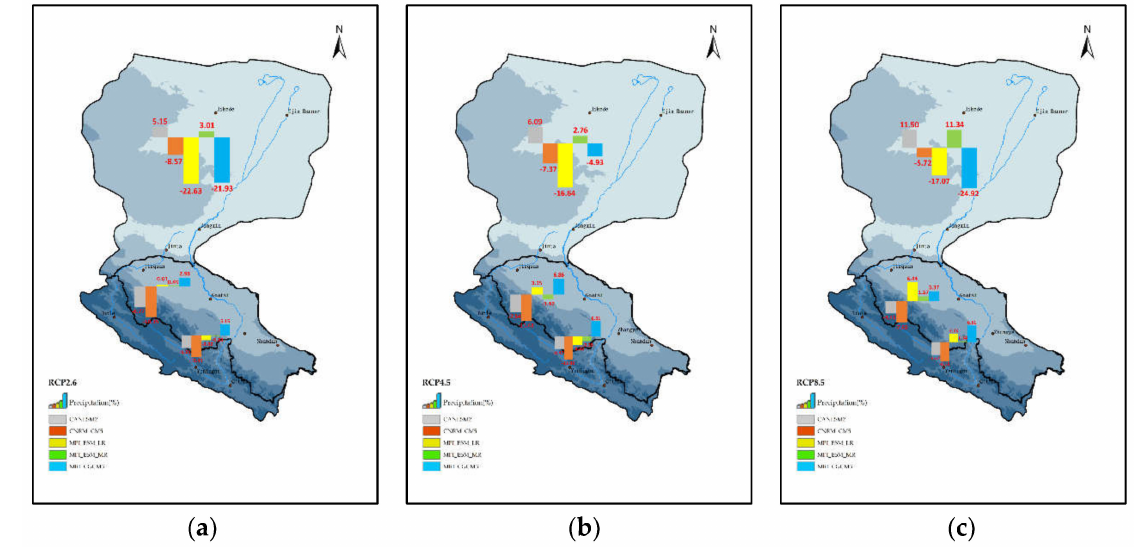
Figure 5. Multi-model projected spatial variations in mean annual precipitation: ( a ) RCP2.6; ( b ) RCP4.5; ( c ) RCP8.5.